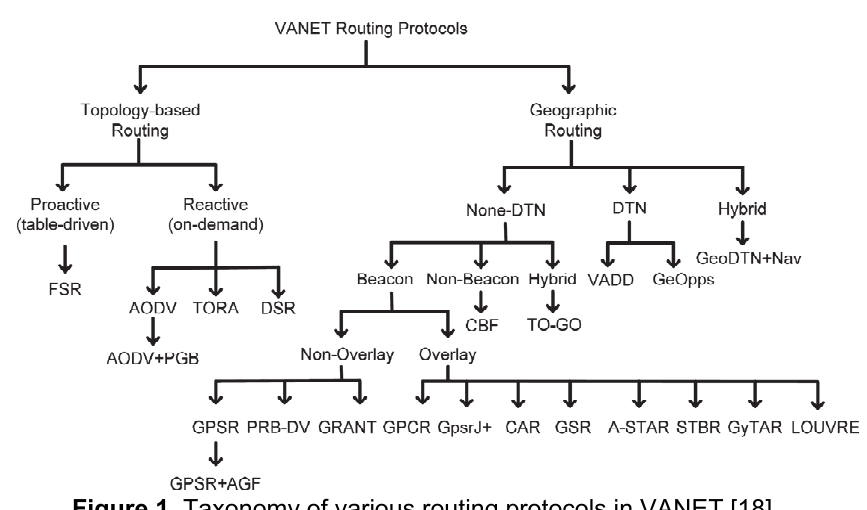
Figure 1. Taxonomy of various routing protocols in VANET